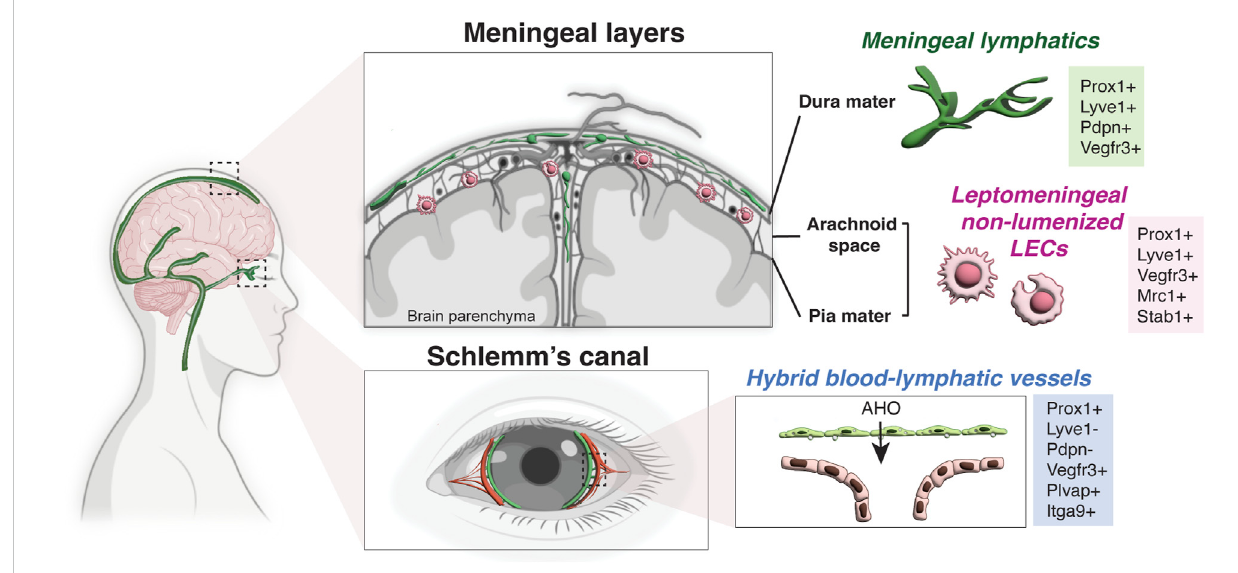
FIGURE 2 Lymphatic endothelial cells in the CNS. Schematic representation of a human brain showing the lymphatic endothelial cells in the meningeal layers andSchlemm ’ scanal.Whilethereisnolymphaticvasculatureinthebrainparenchyma,meningeallymphaticvesselsarefoundintheduramaterunderthe skullandnon-lumenizedmuralLECsarefoundintheleptomeninges (thearachnoid spaceandthepiamater).Meningeallymphaticsexpresstheclassical hallmark of lymphatic vessels (Prox1+ LYVE-1+ PDPN+ VEGFR3+), while non-lumenized mural LECs have macrophage-like shape and express the mannose receptor Mrc1 and Stab1. Note that Schlemm ’ s canal in the eye has hybrid blood-lymphatic vessels, expressing the lymphatic marker Prox1 but not LYVE-1 and PDPN. The hybrid vessels also express high level of VEGFR3, PLVAP and Itg α 9. AHO, aqueous humor out fl ow (Partially created with BioRender.com).